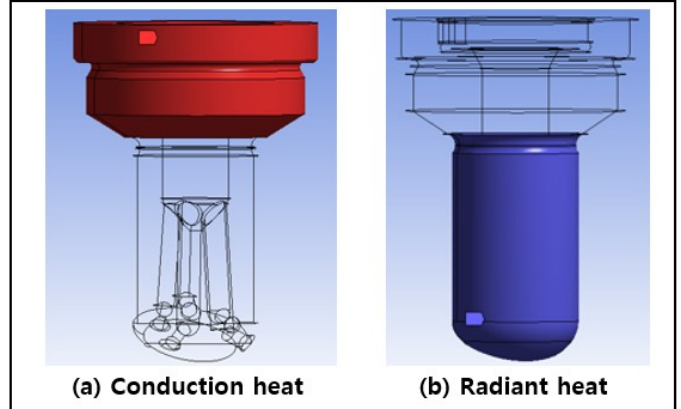
Figure 7. Boundary conditions for structure analysis of the nozzle. Spray simulations were performed for the pressure conditions generated at the inner wall of the nozzle, and the results were applied. In Figure 8a–c, the pressure setting section was divided into three sections, and the pressure in each section was adjusted to uniformly reach the specified boundary surface.